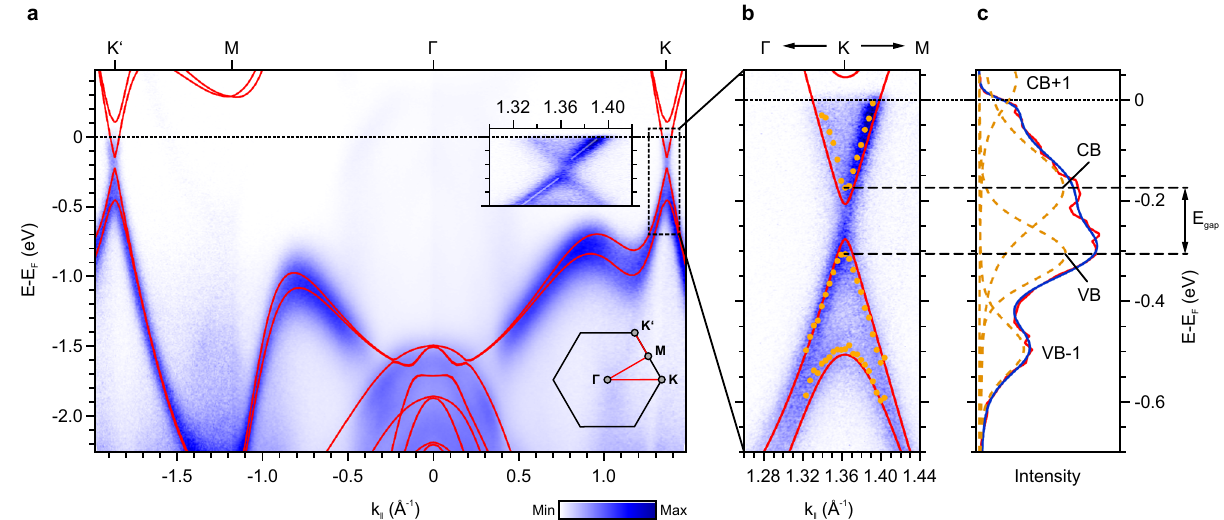
Fig. 4 Band structure of indenene. a Comparison of ARPES and DFT band structure (red) and Brillouin zone schematics for the probed high symmetry lines. The faint dispersive features around the Fermi level are artifacts originating from satellite lines of the non-monochromatized He – I radiation (see “ Methods ” section). The inset shows the dispersive behavior at the K -point on a strongly enlarged momentum scale, illustrating the deviation from an ungapped Dirac double-cone. b Detailed analysis of the K-point dispersions. The orange markers indicate the peak positions obtained from the peak fi tting of the EDCs at selected k-vectors. c EDC at the K -point (red) and its peak- fi t (blue — sum, orange dashed lines — peaks) accounting for the fi rst two valence band states (VB, VB-1) and the lowest conduction band